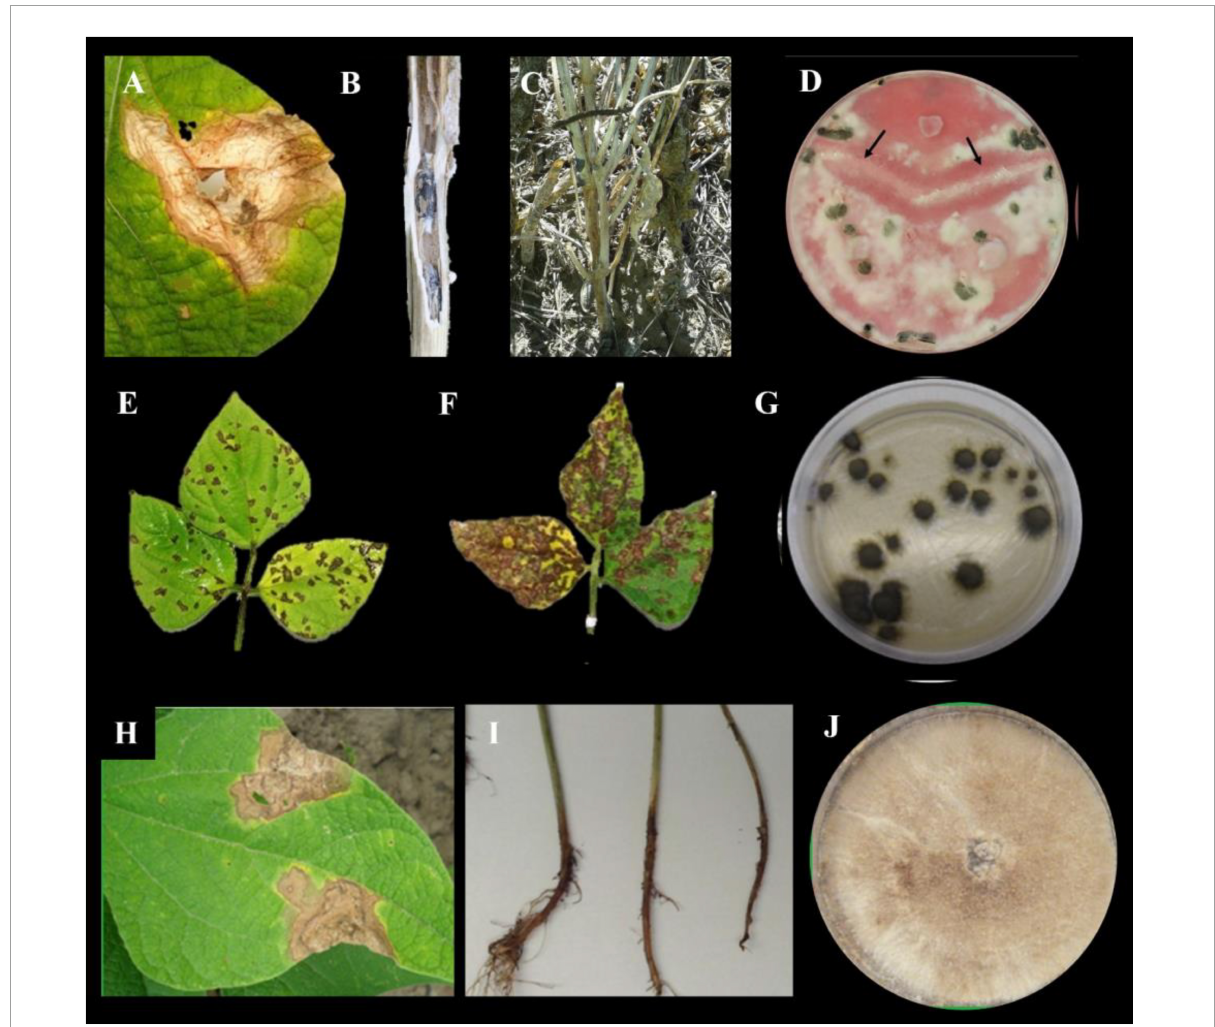
FIGURE1 White mold symptoms on common bean (A) leaf and (B) stem. (C) Common bean cultivar showing white mold symptoms. (D) Mycelial compatibility test between three isolates of Sclerotinia sclerotiorum . The arrows indicate incompatible reactions with band of aerial mycelium in the interaction zone. (E,F) Common bean cultivars showing a susceptible reaction to Pseudocercospora griseola . (G) Andean P. griseola isolate. (H) Web blight symptoms on common bean leaf. (I) Rhizoctonia root rot symptoms on common bean. (J) Rhizoctonia solani isolates obtained from common bean seed and